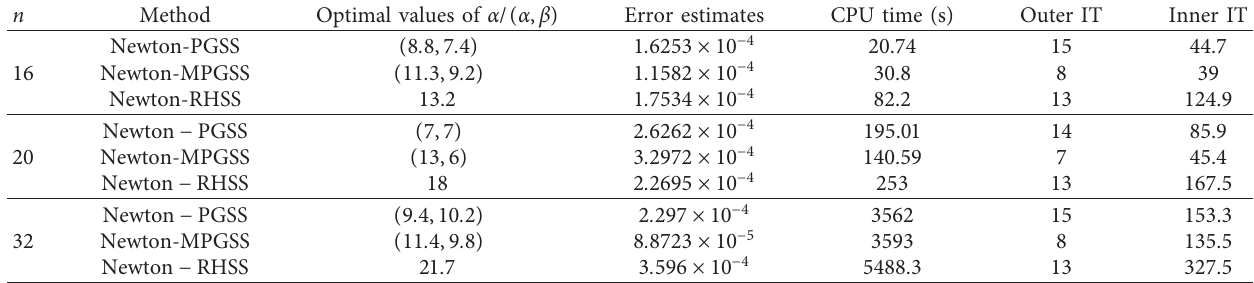
Table 2: Numerical results of inexact methods for v � 1 and η � 0.4.